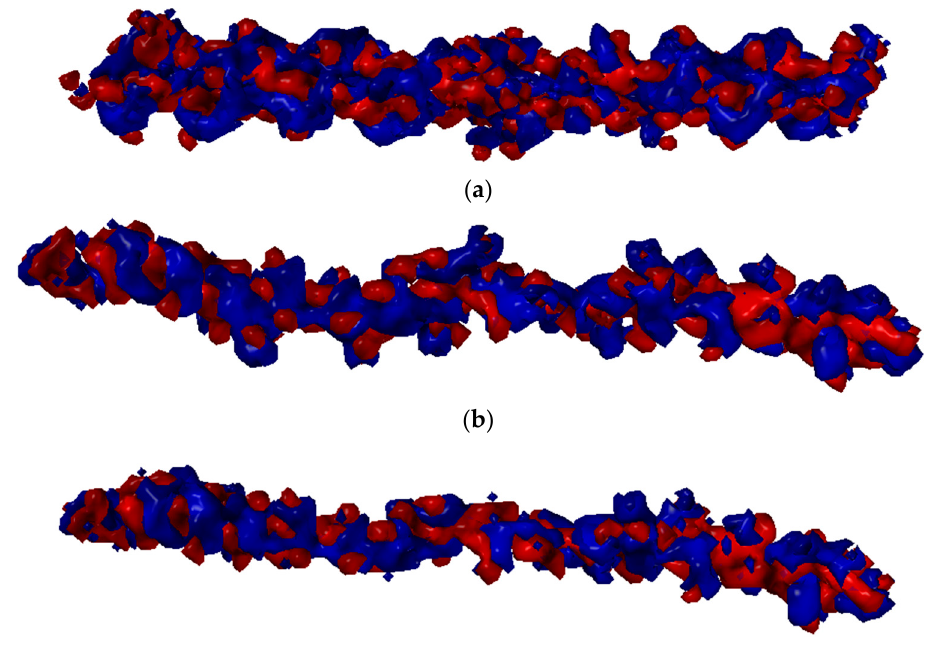
Figure 5. Distribution of H-bonds for most important amino acids vs. deacetylation degree (DD) of Chitosan and H-bonds distribution in hyaluronic acid–collagen complex (HA).